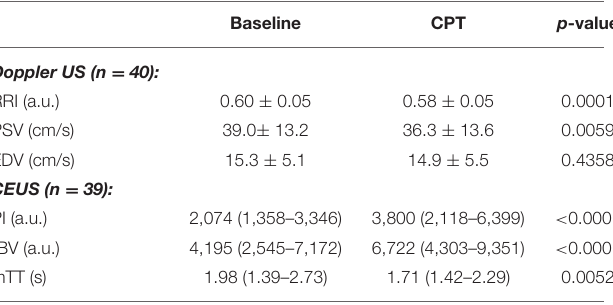
TABLE 2 | Renal hemodynamic during baseline and CPT. Baseline CPT p -value